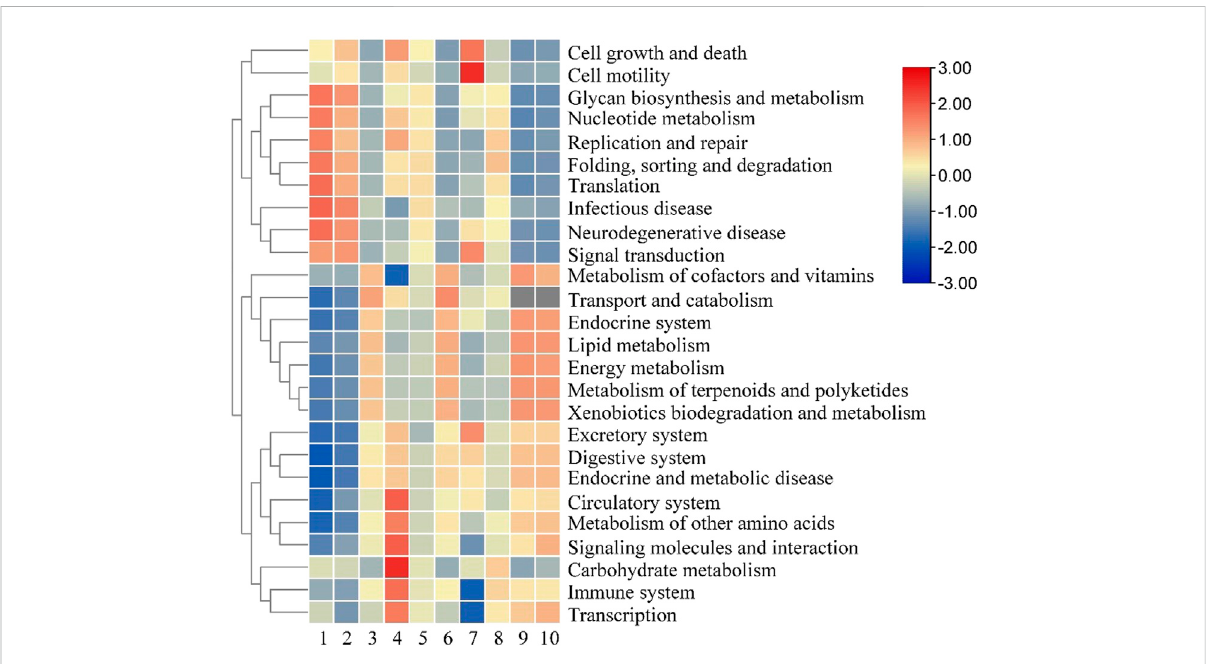
FIGURE 8 Analysisofbacterialgenesincigartobaccoleaves.Note:1to5wererespectivelyaddedwaterandfermentedfor0d,2d,4d,6d,8d,6-10were followed by medium fermentation for 0 d, 2 d, 4 d, 6 d, 8